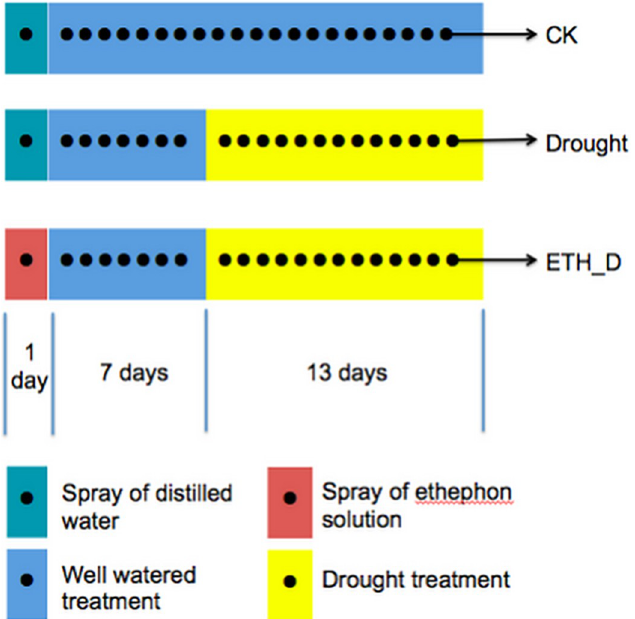
Fig 1. Schematic overview of the experimental design for well-watered control plants without ethephon application (CK), drought control plants without ehtphon application (Drought), and drought control plants with ethephon pre-treatment (ETH_D). CK means well-watered control plants without ethephon application. Drought means drought-stressed plants without ethephon application. ETH_D means drought-stressed plants with ethephon